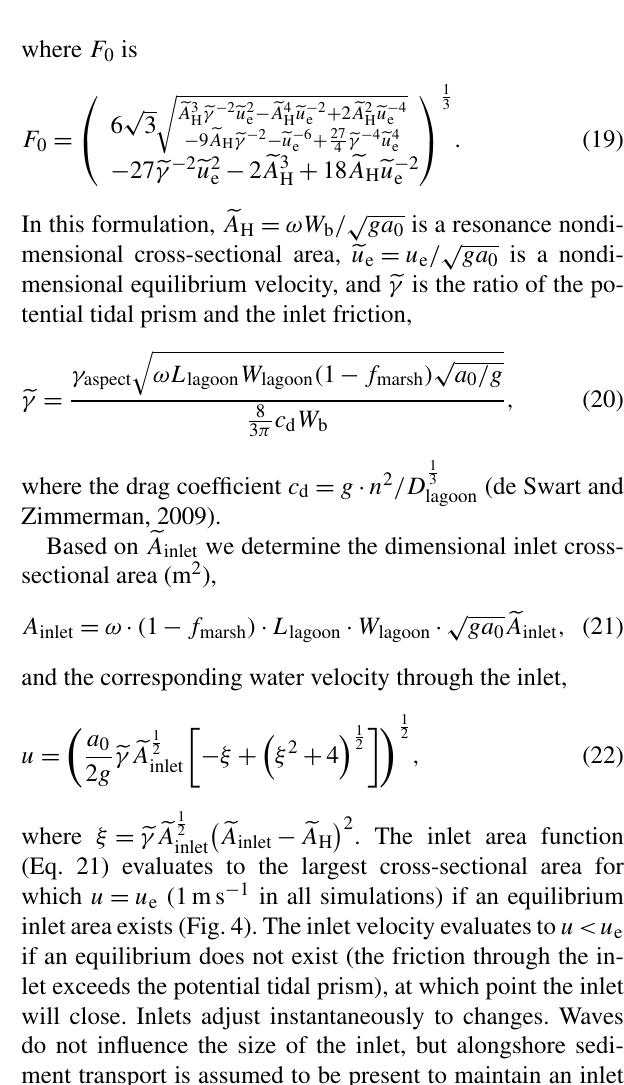
Figure 3. Effect of lagoon depth (fine sediment fraction) on (a) the overwash flux, (b) the barrier width, and (c) the shoreline location. More overwash flux is needed to maintain a barrier with a deep lagoon, resulting in barrier drowning for a lagoon depth of > 8m, where the required barrier overwash flux is greater than the maximum potential overwash flux Q ow , max